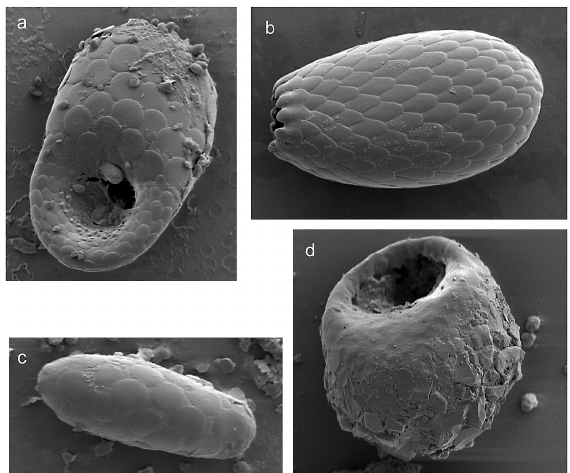
Fig. 3. SEM micrographs of dominant testate amoebae; idiosomic taxa: (a) Trinema complanatum (length=46µm), (b) Euglypha ro- tunda (length=49µm), (c) Trinema lineare (length=23µm); xeno- somic taxa: (d) Centropyxis sphagnicola